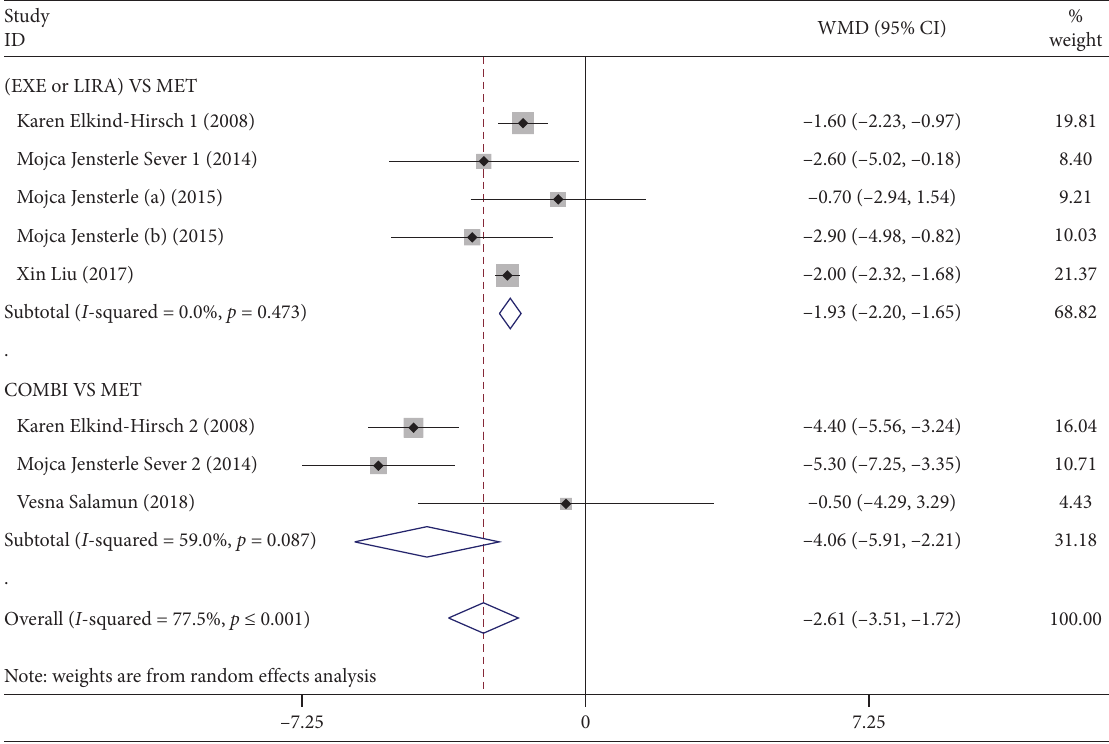
Figure 2: Forest plot of the outcome of weight loss effect in overweight/obese. PCOS patients. EXE: exenatide; LIRA: liraglutide; MET: metformin; COMBI: combination, represented GLP-1RAs combined with MET treatment; WMD: weighted mean